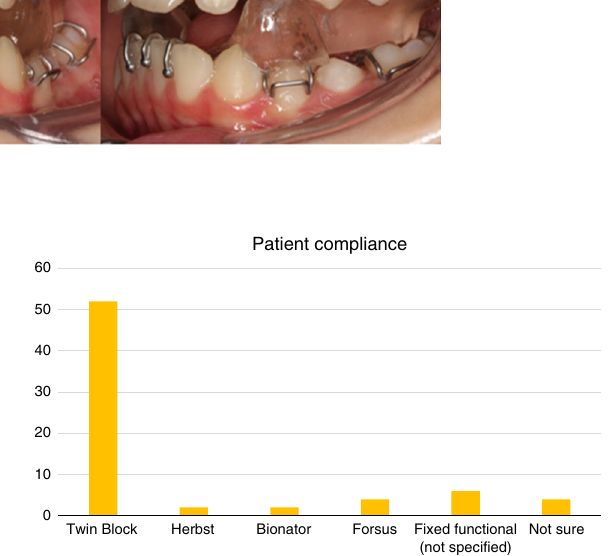
Figure 3. Popularity of functional appliances used in Malaysia.